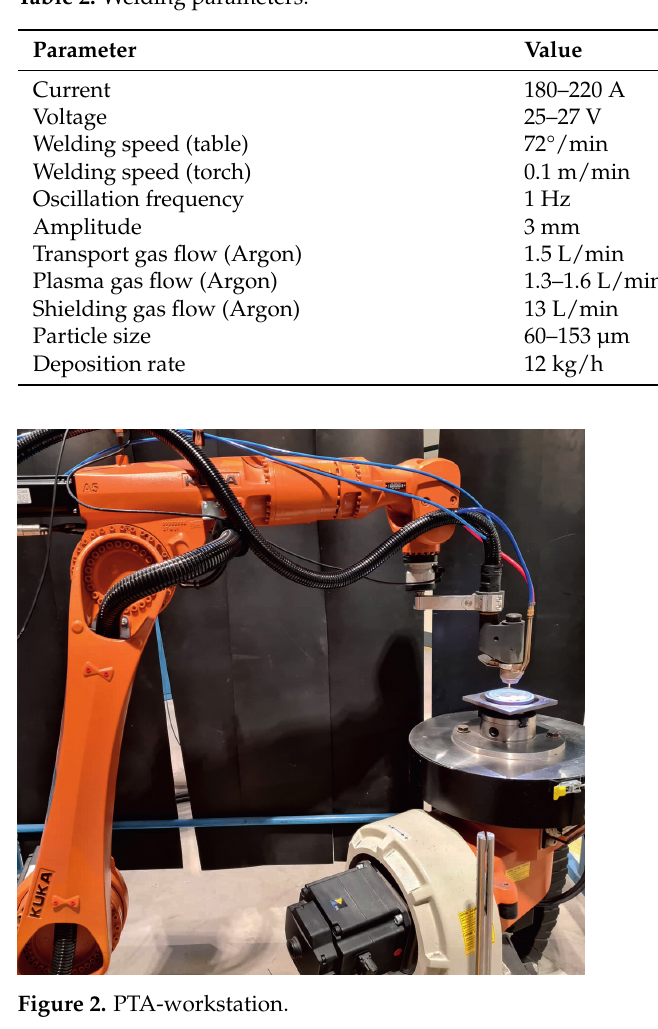
Table 2. Welding parameters.